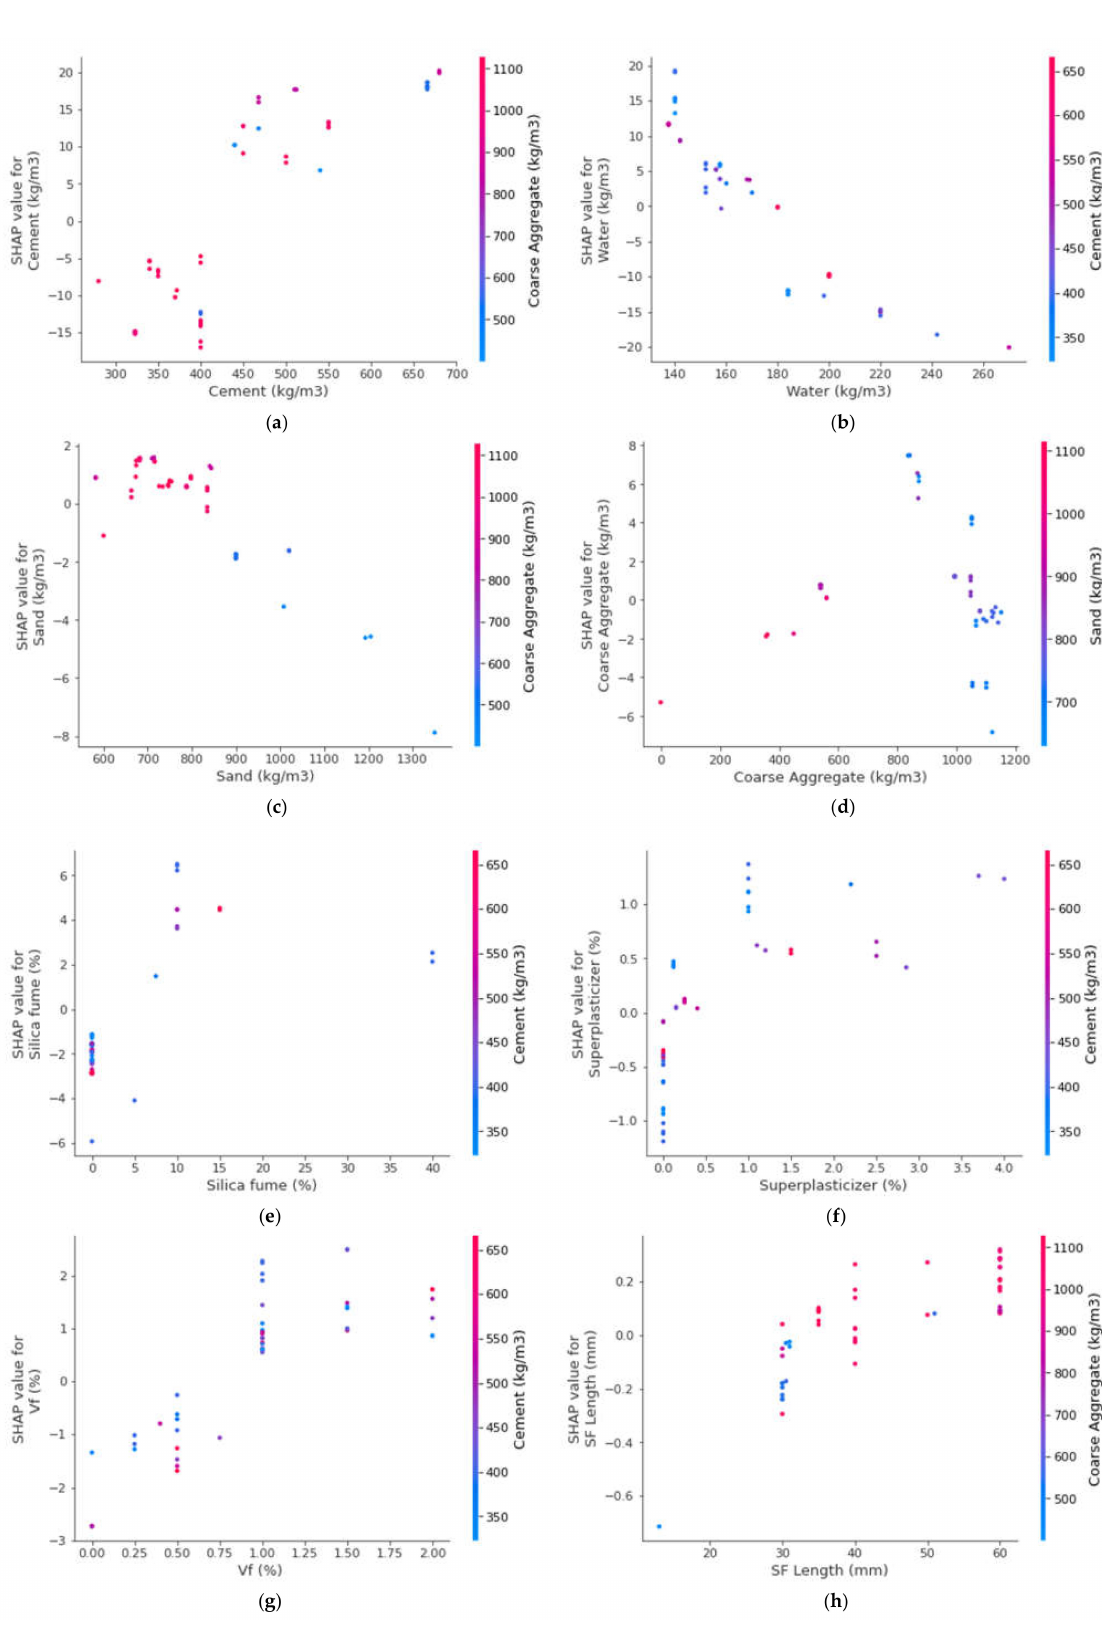
Figure 17. Interaction plots of various parameters: ( a ) cement; ( b ) water; ( c ) sand; ( d ) coarse aggregates; ( e ) silica fume; ( f ) super-plasticizer; ( g ) V f ; and ( h ) fiber